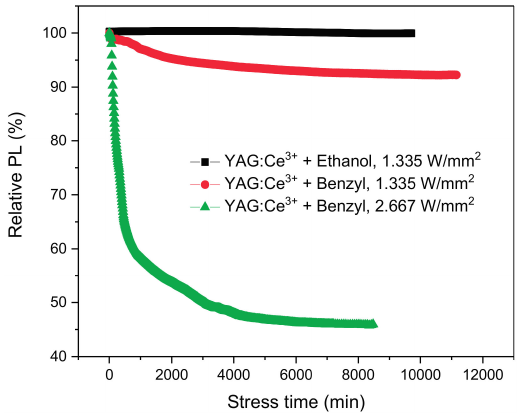
Figure 2. Degradation at constant optical power stress, comparison of ethanol and benzyl alcohol